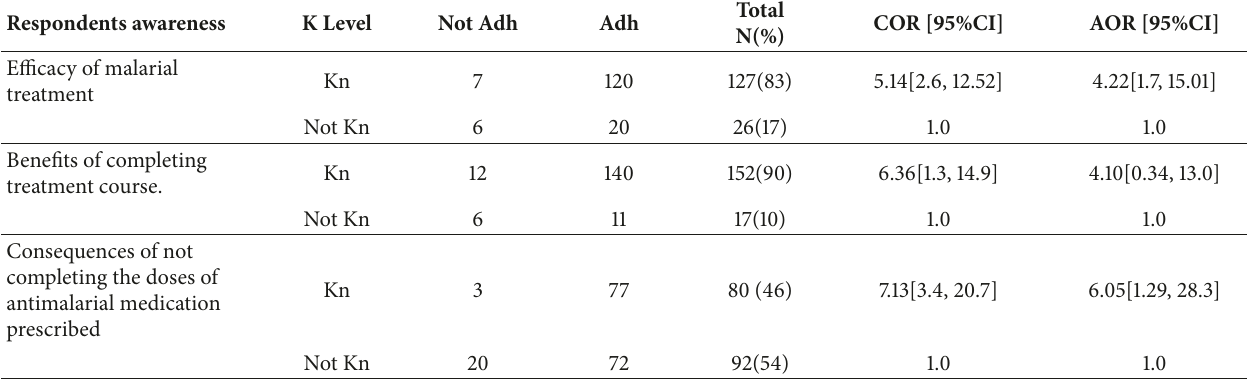
Table 4: Bivariate and multivariable logistic regression analysis of patient knowledge on antimalarial treatment (ACTs) with adherence. Respondents